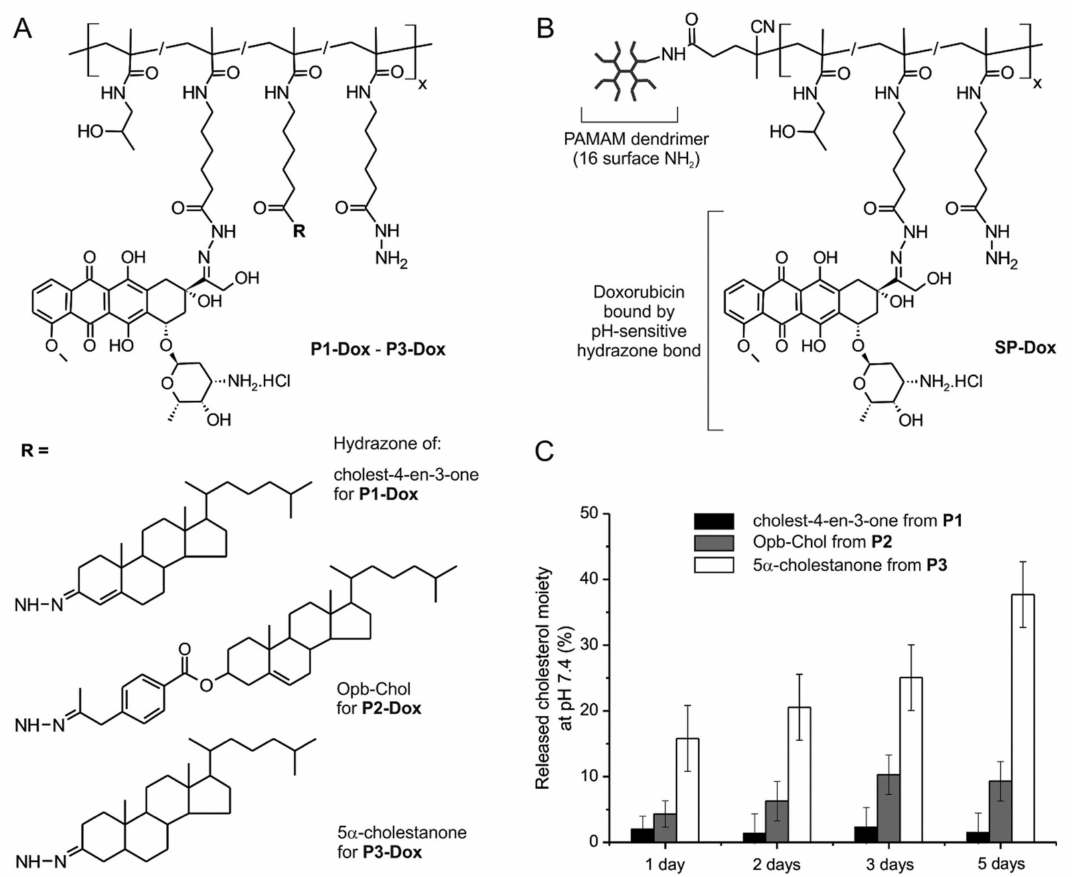
Figure 5. Schematic structure of amphiphilic pHPMA − doxorubicin (Dox) conjugates P1–P3 differing in the hydrophobic moiety ( A ) and star pHPMA − Dox conjugate ( B ). Release of cholesterol moieties from copolymers P1 − P3 at pH 7.4 and 37 ◦ C, mimicking the bloodstream environment ( C ). Reprinted with permission from [82]. Copyright© American Chemical Society